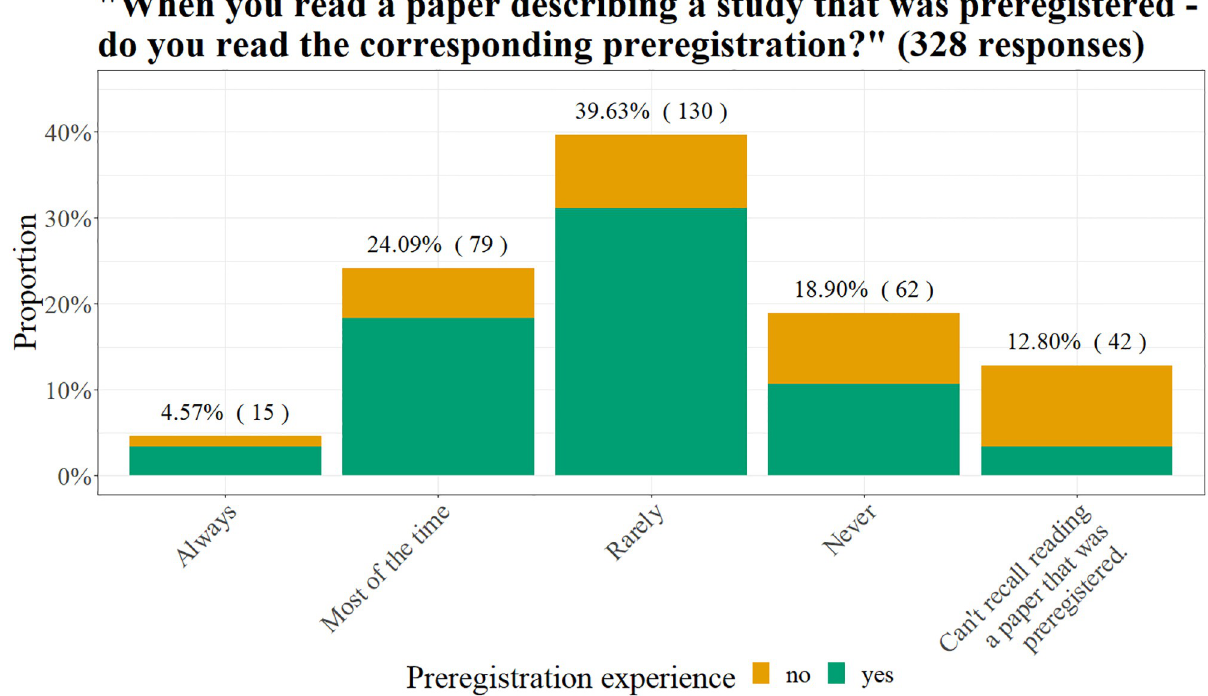
Fig 4. How often do participants read preregistrations. Above each bar, the percentage (frequency) of participants who selected the respective answer is shown.